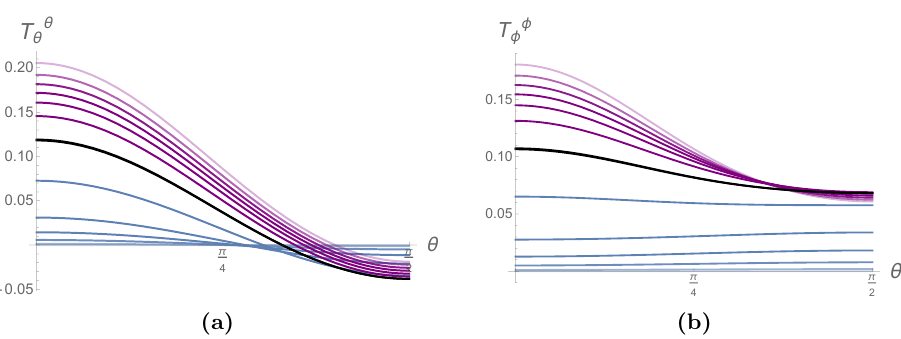
Figure 4. Spatial components of the boundary stress tensor for